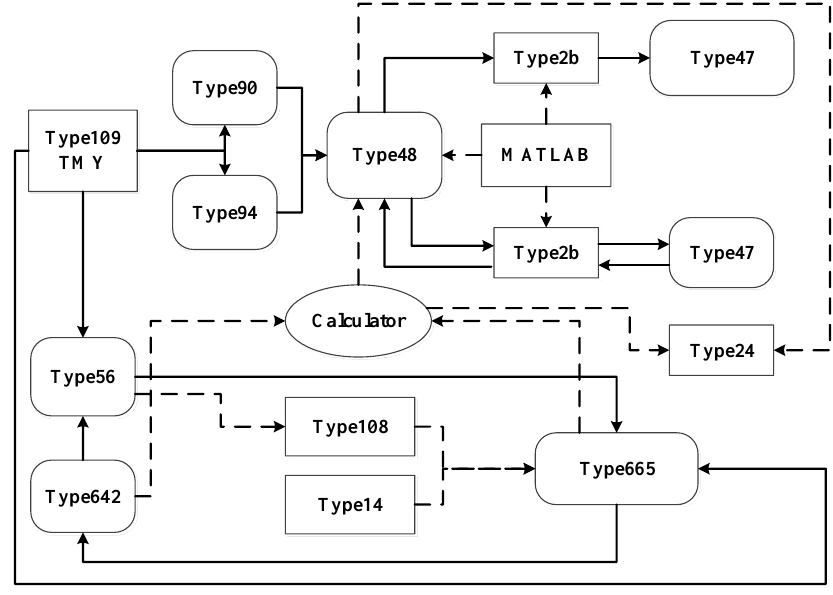
Figure 2. Schematic diagram of building energy system in MATLAB-TRNSYS.